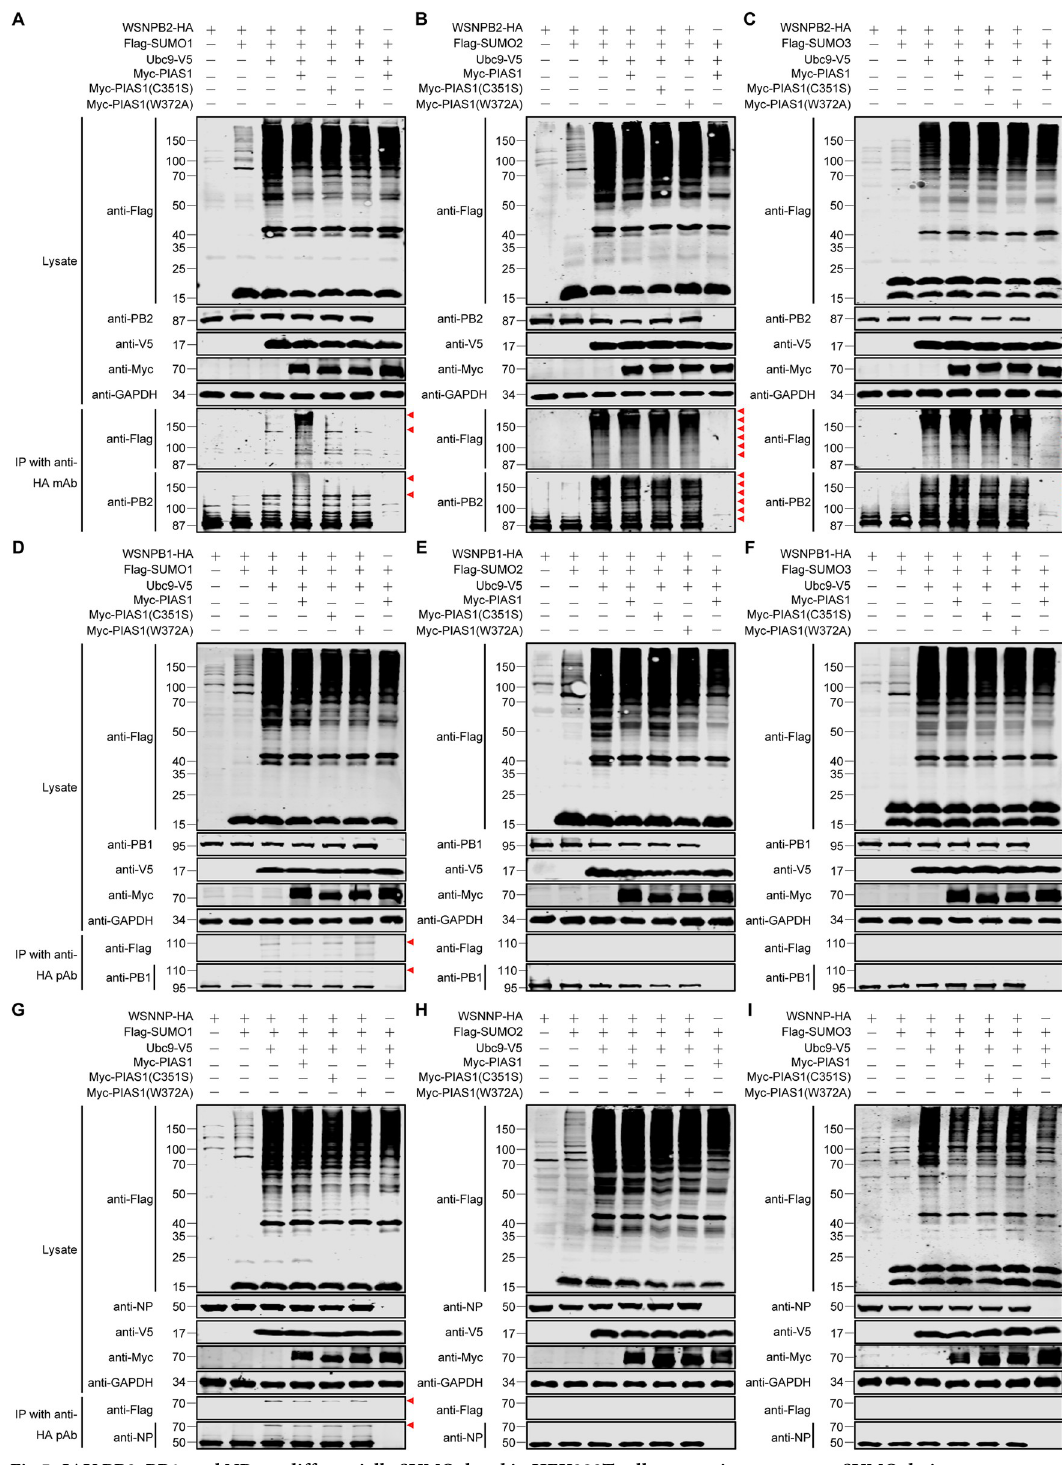
Fig 5. IAV PB2, PB1, and NP are differentially SUMOylated in HEK293T cells expressing exogenous SUMOylation components. (A-I) HEK293T cells were transfected with plasmids expressing HA-tagged WSNPB2 (A-C), WSNPB1 (D-F), or WSNNP (G-I), along with or without Flag-SUMO1/2/3, Ubc9-V5, and Myc-PIAS1 or its mutant. HEK293T cells transfected to express only Flag-SUMO1/ 2/3, Ubc9-V5, and Myc-PIAS1 served as a negative control. At 36 h post-transfection, cell lysates were immunoprecipitated with a mouse anti-HA mAb (A-C) or a rabbit anti-HA pAb (D-I), and were then subjected to western blotting with a rabbit anti-PB2